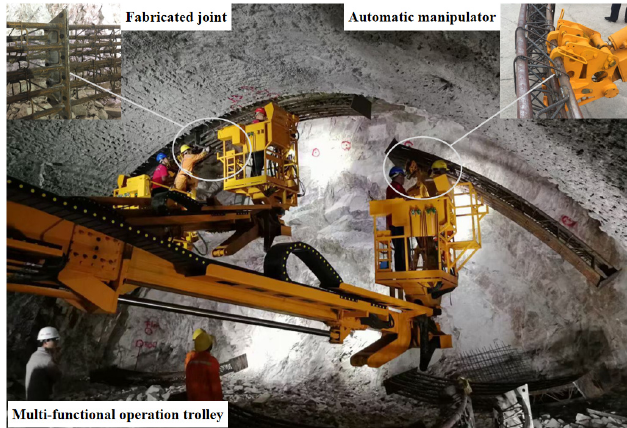
Figure 22. Construction system of the prefabricated SRS arch support.